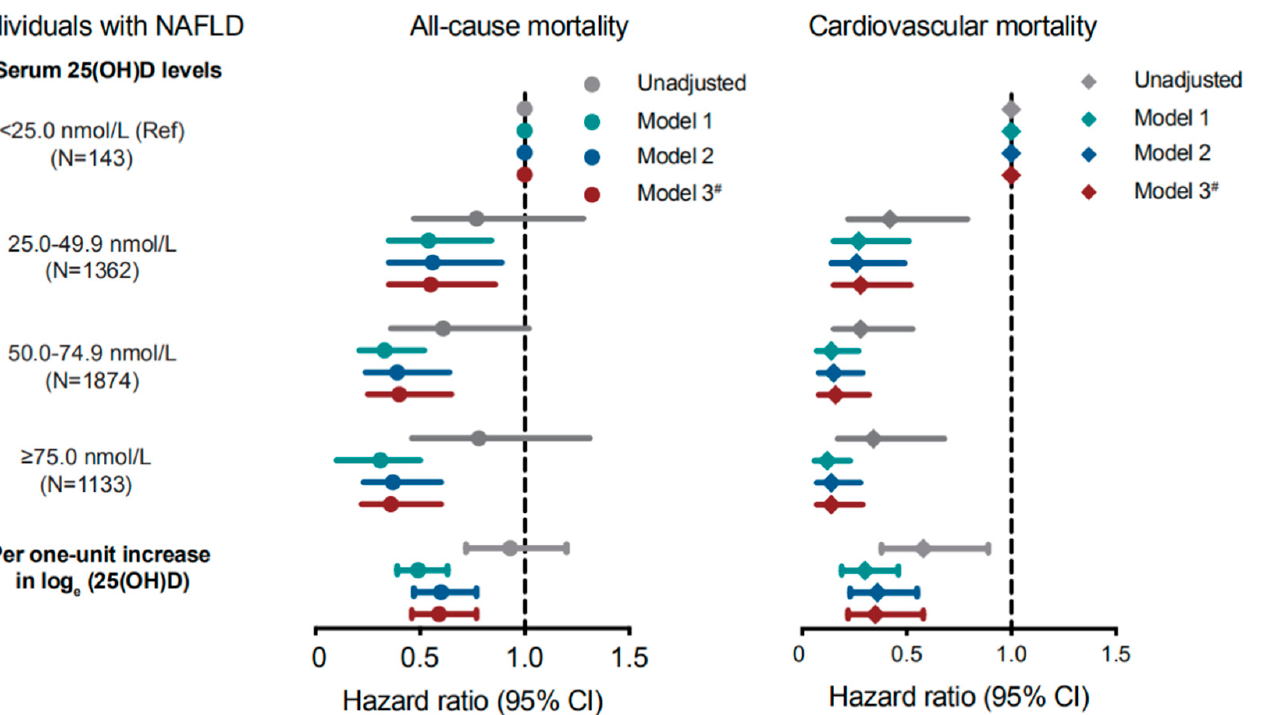
Figure 2. HRs (95% CIs) for all-cause and cardiovascular mortality based on serum 25(OH)D levels among NAFLD patients in NHANES, 2001–2016. HRs are shown as dots and cyan diamonds and 95% CIs as horizontal lines for all-cause and cardiovascular mortality, respectively. Model 1: adjusted for age, sex, and race/ethnicity. Model 2: further adjusted for all covariates in Model 1 and education level, PIR, smoking status, physical activity, and BMI. Model 3 (fully adjusted model): further adjusted for all covariates in Model 2 and hypertension, diabetes, hyperlipidemia, CVD, eGFR, and steroid use. # All 95% CIs from Model 3 were adjusted using Hochberg step-up procedure. Abbreviations: HRs, hazard ratios; CIs, confidence intervals; NAFLD, nonalcoholic fatty liver disease; NHANES, National Health and Nutrition Examination Survey; PIR, family poverty income ratio, BMI, body mass index; CVD, cardiovascular disease; eGFR, estimated glomerular filtration rate.